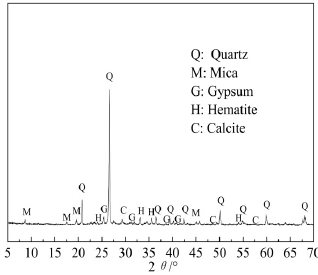
Figure 1. X-ray diffraction (XRD) pattern for roasted stone coal.